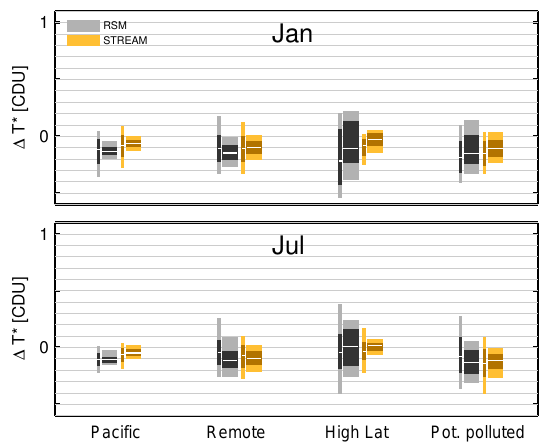
Figure 7. Regional statistics of the error of T ∗ from STREAM, i.e., the difference of estimated and a priori TR (based on synthetic total columns as defined in Sect.